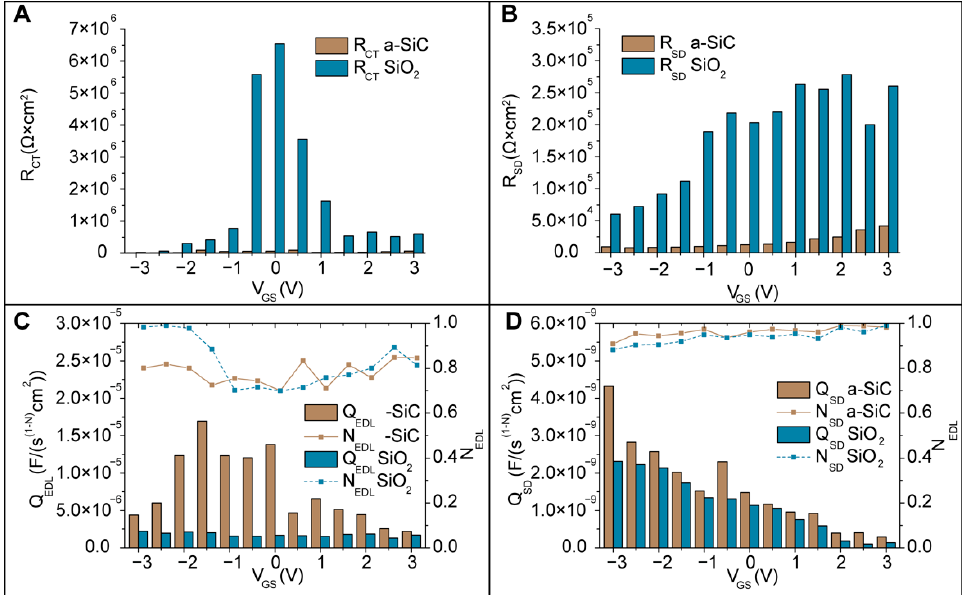
Figure 9. Comparison between the fitted values for a-SiC and SiO 2 . ( A ) R CT charge transfer resistance; ( B ) R SD resistance of the polysilicon; ( C ) Q EDL constant phase element and its n EDL factor associated with the EDL; ( D ) Q SD constant phase element and its n SD factor associated with the polysilicon.